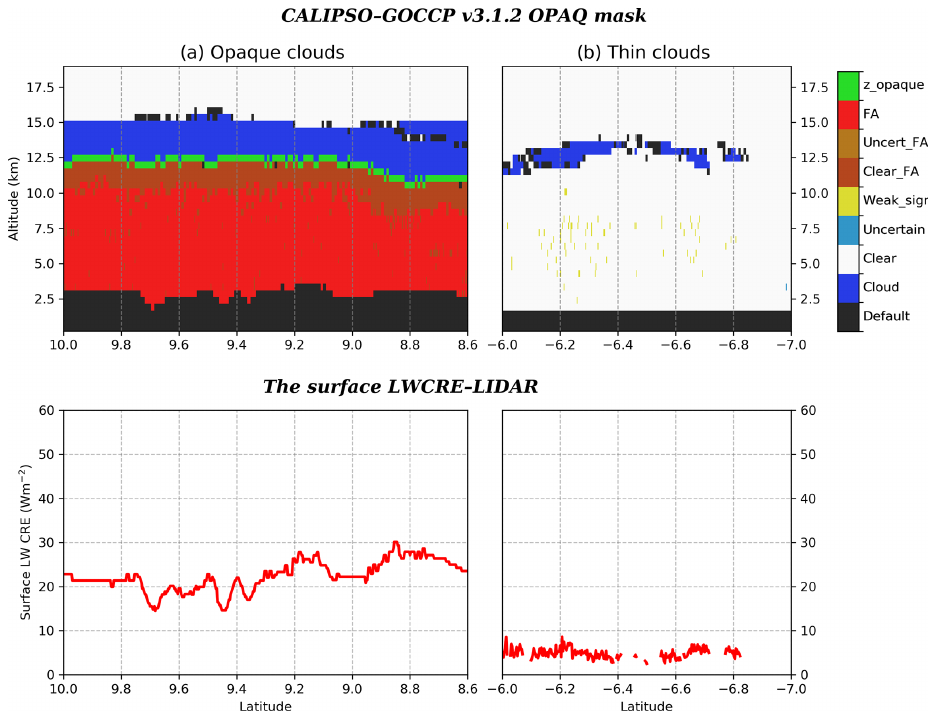
Figure 7. Pieces of the CALIPSO orbit passing over Africa on 11 August 2010 at 23:02:38LST. Opaque clouds (left column) and thin clouds (right column). Top line: vertical feature mask from the CALIPSO–GOCCP–OPAQ product (Guzman et al., 20017); the black areas below 4km correspond to land. Bottom line: the surface